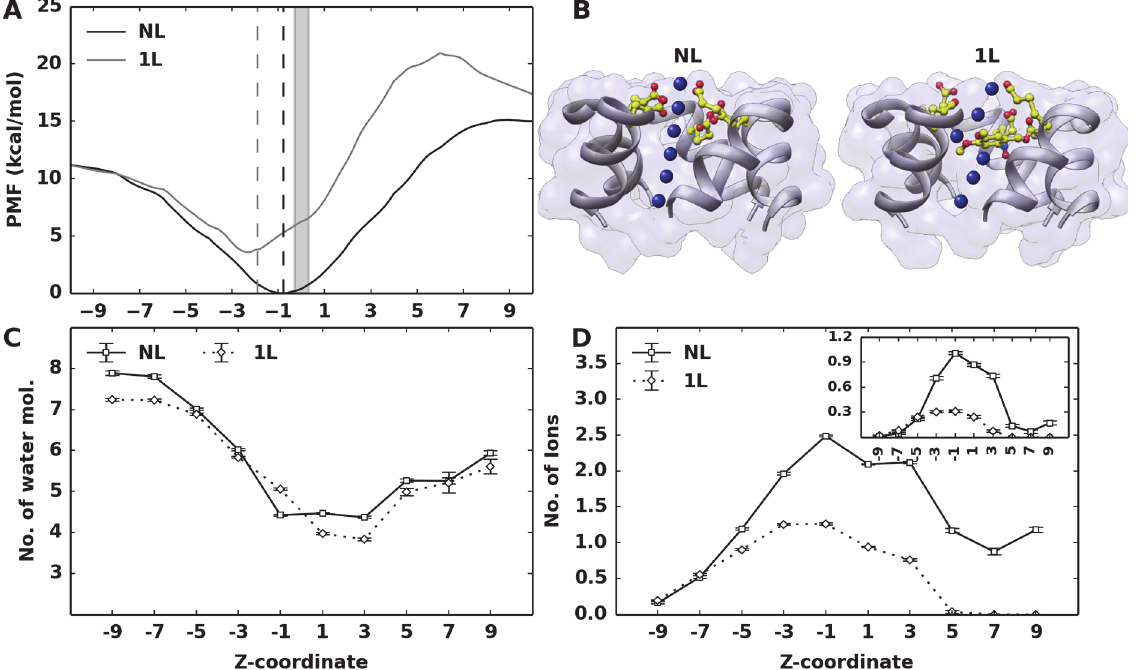
Fig 3. PMF profile, water and ion coordination around the potassium ion. (A) PMF profile as a function of the z-coordinate. The origin was set at the C α geometric centroid of the mutated site. Vertical dashed lines indicate the average location of the acetate group oxygens centroid with respect to the origin. (B) Schematic view of ion exit pathway from the mutated site. The charged group (NL) and the bulky ligand (1L) are shown in yellow. Blue spheres inside the pore represents the K + ion. (C) Average number of water molecules and (D) potassium ions within a radius of 3.5 and 5 Ang, respectively, around the permeating K + ion. Data obtained with a smaller radius (4 Ang) is shown in the inset.